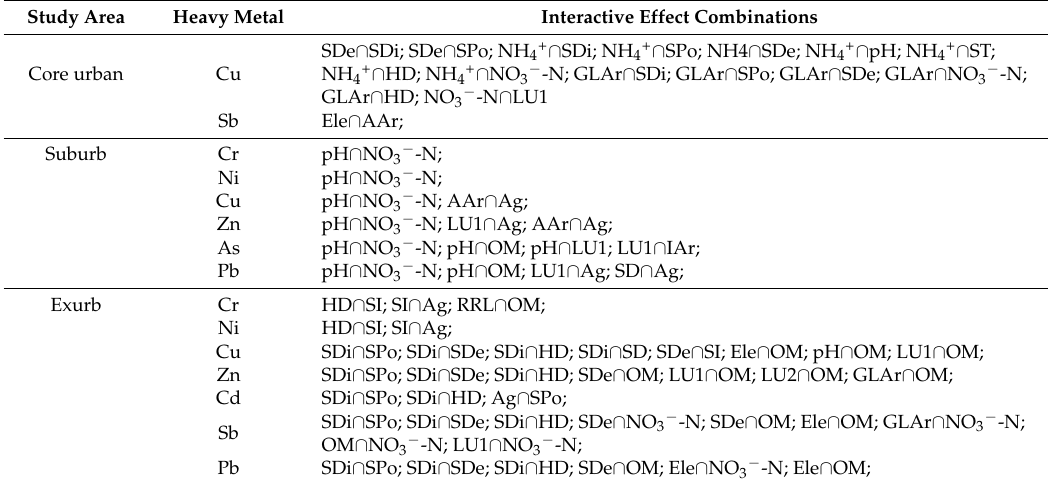
Table 6. Combinations of nonlinear increase more than